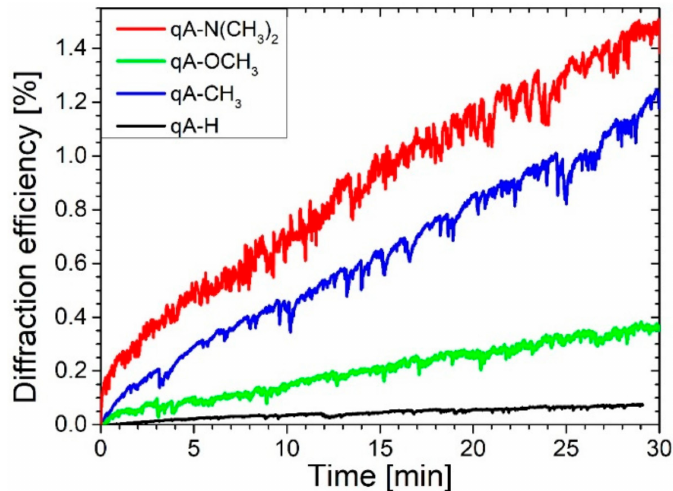
Figure 8. The first order di ff raction e ffi ciency as a function of time for the quinoline azo-dye polymers